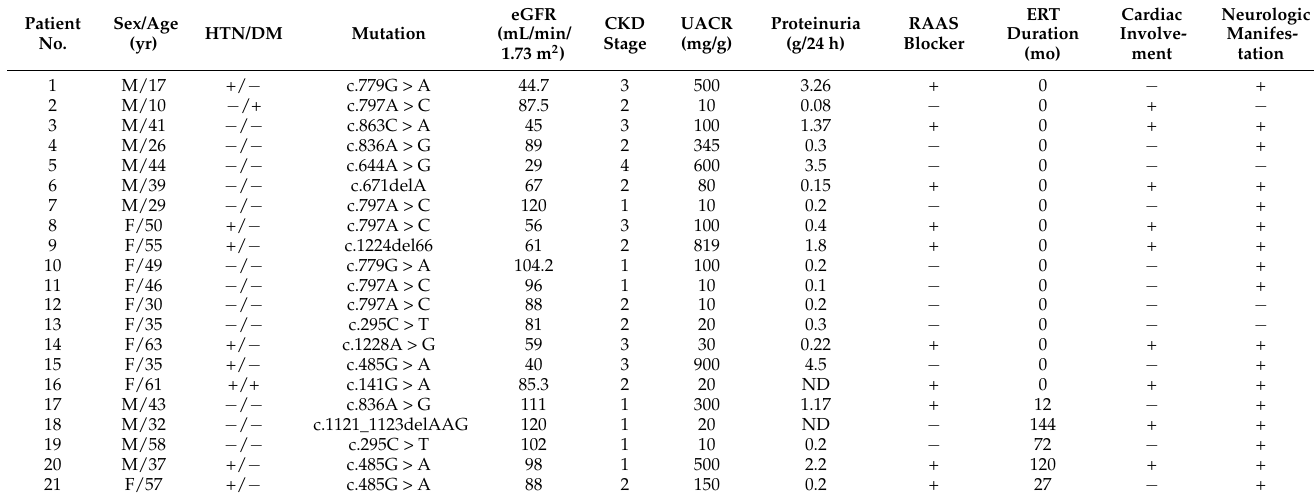
Table 1. Baseline characteristics of the study